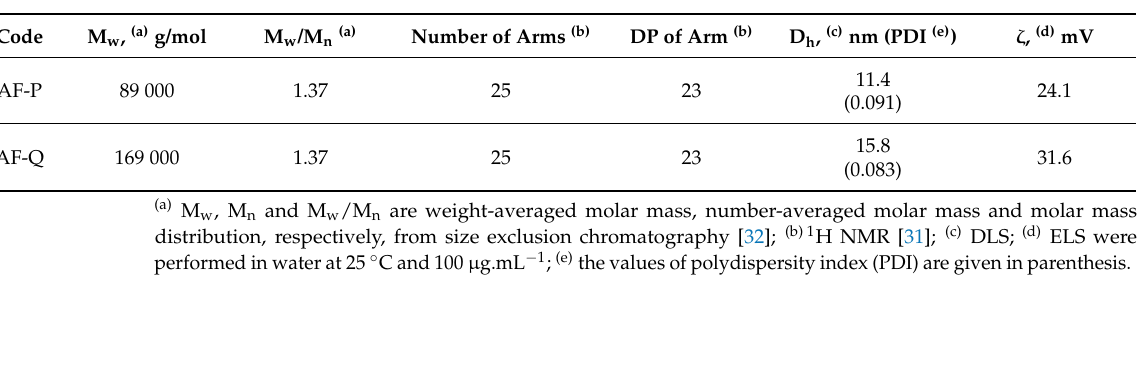
Table 1. Molecular and physicochemical characteristics of PDMAEMA star-shaped